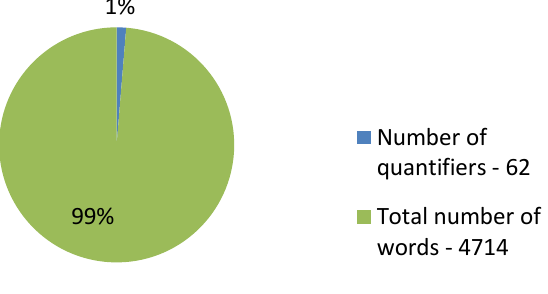
Fig. 1 – Expression of identifies in